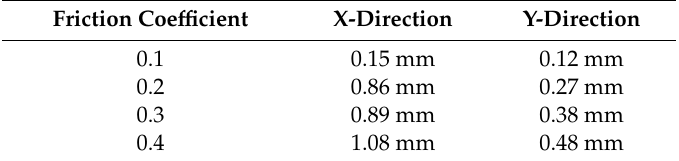
Figure 11. Trajectory curve of BHA center under different friction coefficients: ( a–d ) are the numerical simulation results with 0.1, 0.2, 0.3, and 0.4 respectively. Table 12. Lateral displacement of BHA under different friction coefficients in numerical simulation.